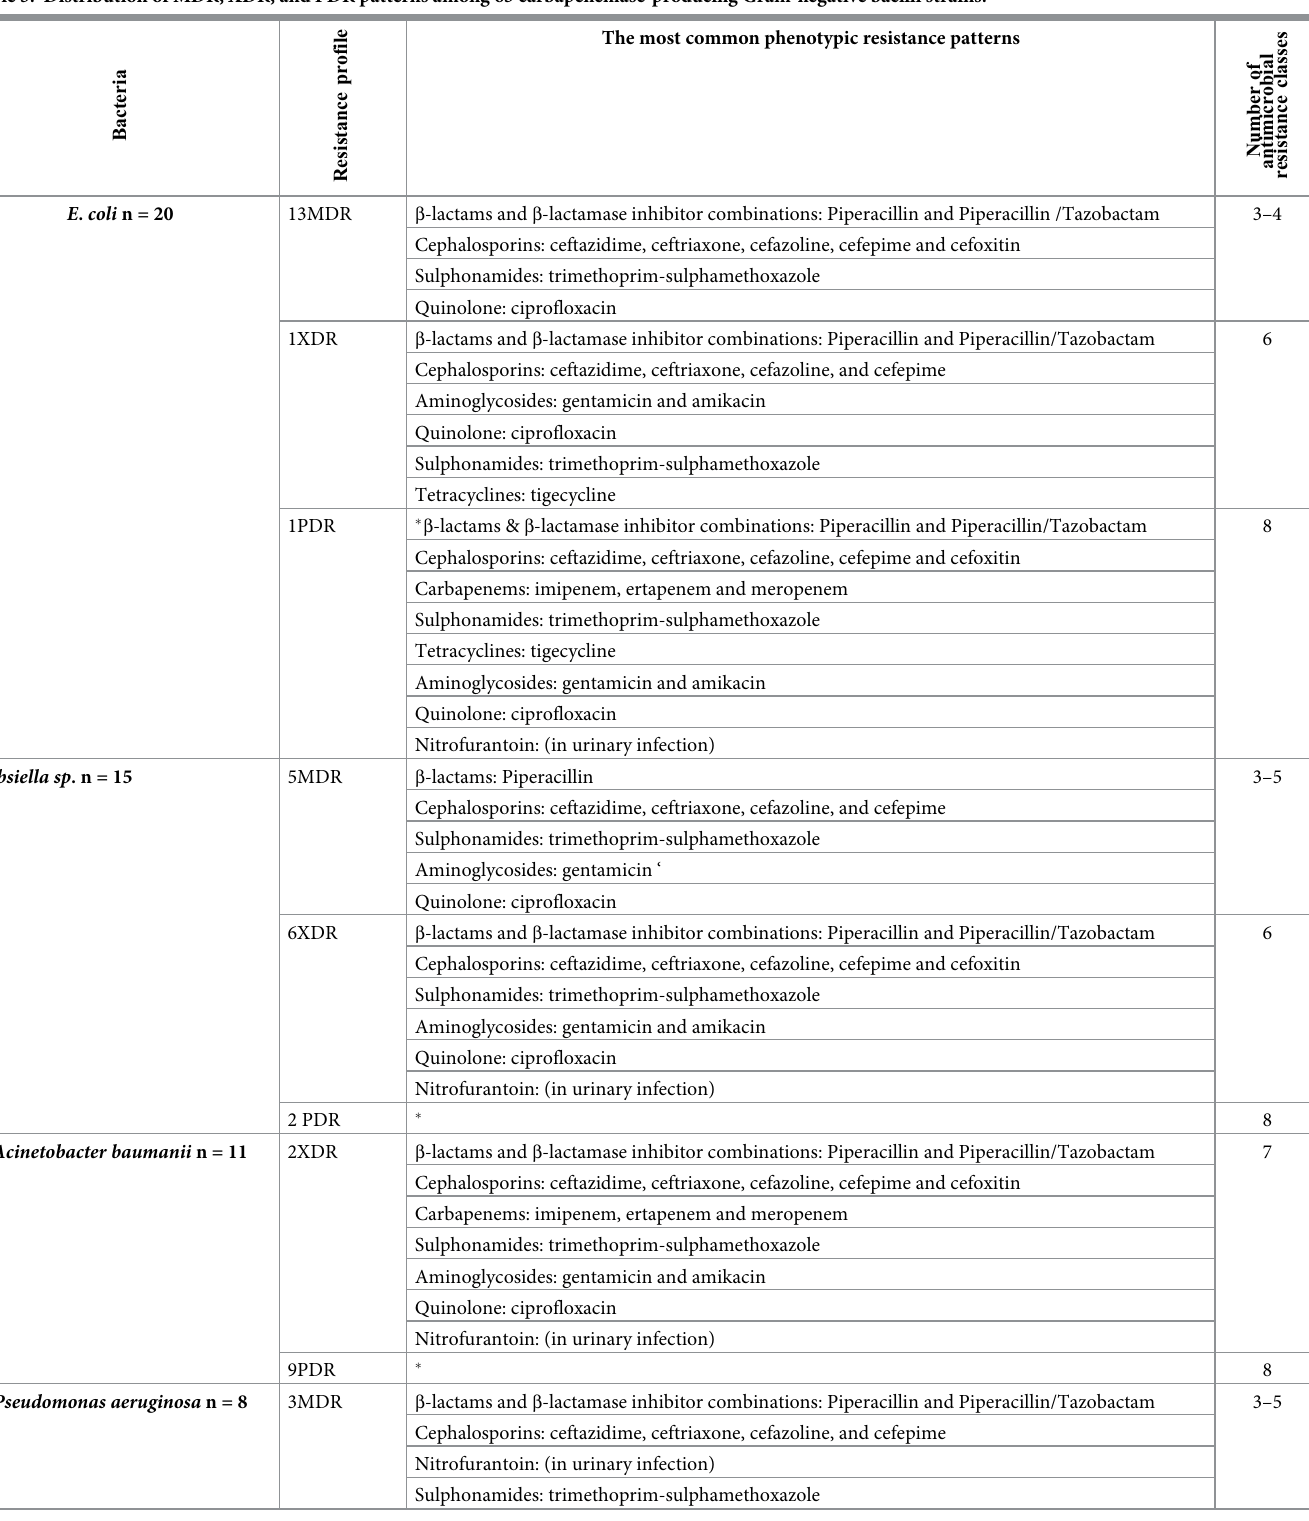
Table 3. Distribution of MDR, XDR, and PDR patterns among 65 carbapenemase-producing Gram-negative bacilli